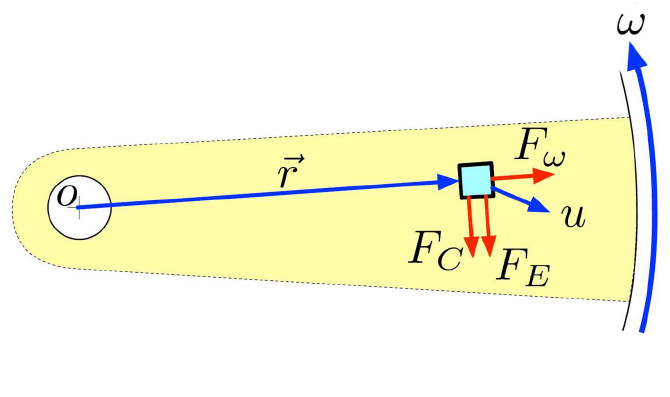
Figure 2. Illustration of forces utilized to control fluids on centrifugal microfluidic platforms, including the centrifugal force ( F ω ), Coriolis force ( F C ) and Euler force ( F E ). Kinematic quantities (blue) and forces (red) are shown for a fluid element moving at a velocity ( u ) on a portion of a disc at a distance ¯ r from the center of the